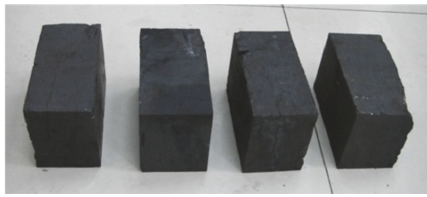
Figure 5: Coal specimens.